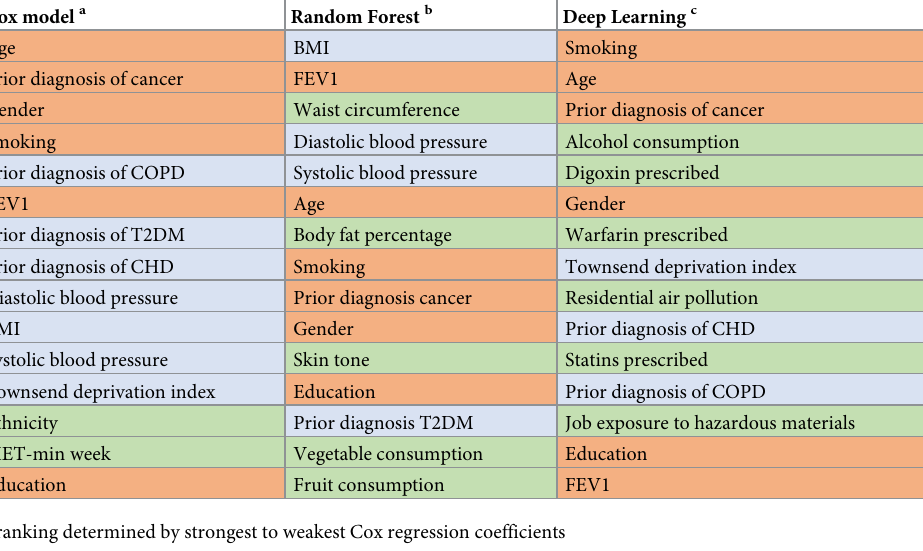
Table 3. Top 15 risk factor variables for predicting mortality listed in descending order of “importance” by algo- rithm derived from the training cohort of 376,971 patients. Cox model a Random Forest b Age